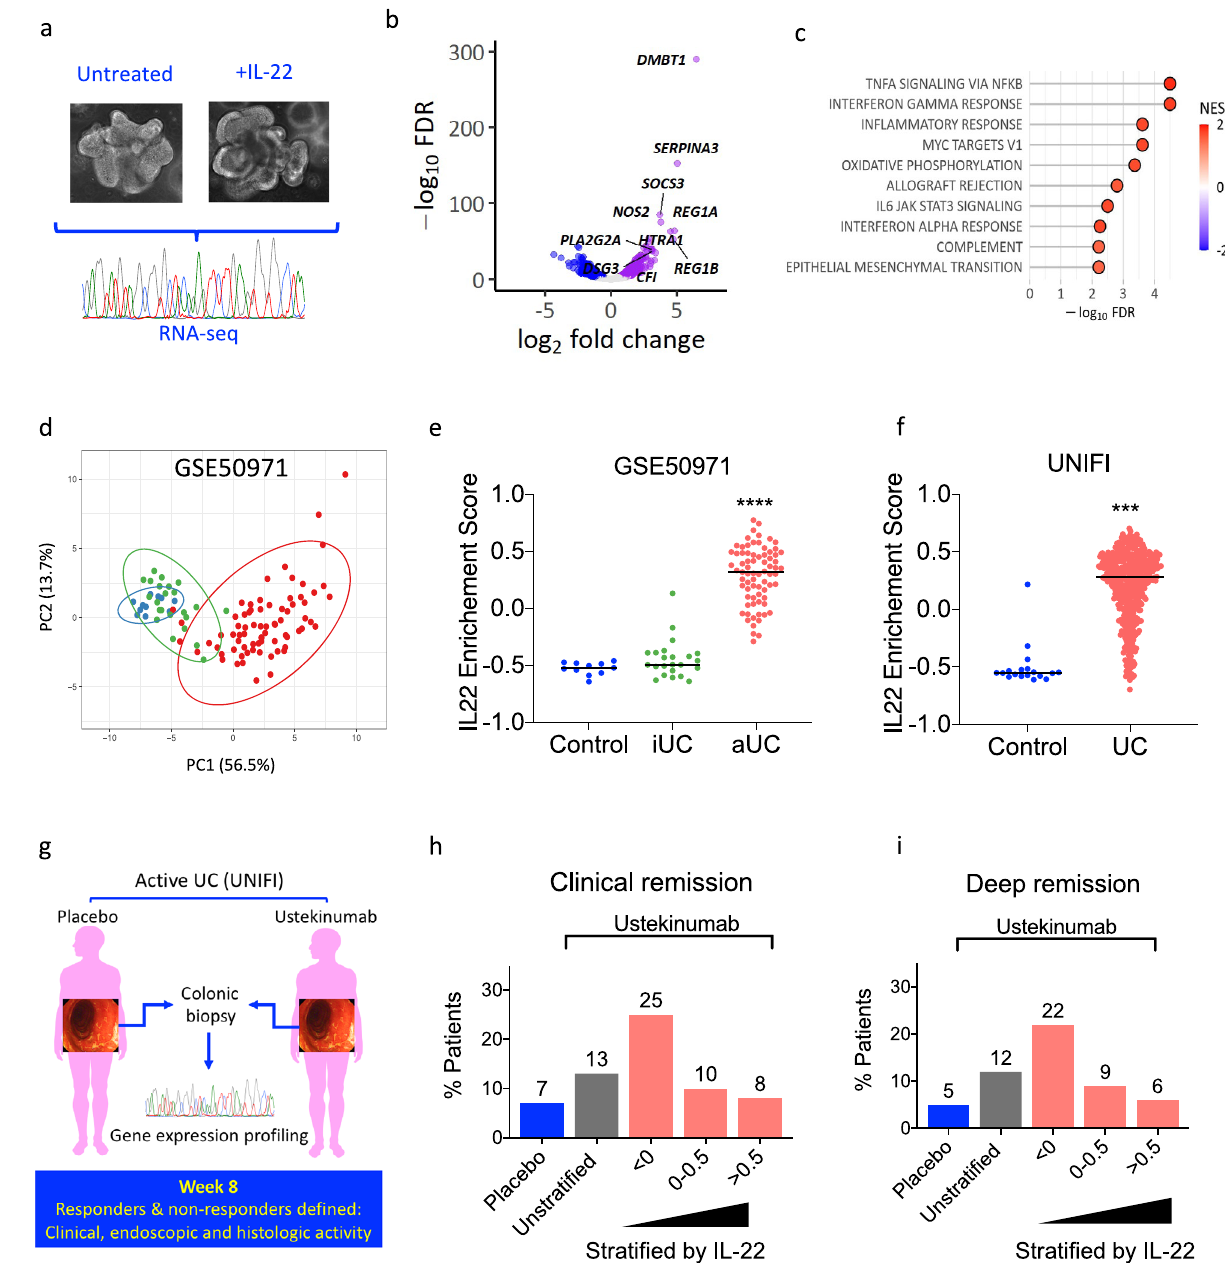
Fig. 1 | Clinical signi fi cance of the IL-22 responsive transcriptional network in ulcerativecolitis.a ExperimentalschemaofIL-22stimulationofcolonicorganoids ( n =4 biological replicates, IL-22 concentration: 10ng/ml, duration: 24h). b Volcano plot demonstrating fold change and false discovery rate (FDR) of dif- ferentially expressed genes in human colonoids treated with recombinant IL-22. c Pathwayanalysisof DEGregulated by IL-22 (top 10,hallmarkgene sets asde fi ned in MSigDB, NES: normalized enrichment score). d Expression of the top 50 upre- gulatedtranscriptsregulatedbyIL-22incolonicmucosaseparateshealthycontrols (blue, n =11),patientswithendoscopicallyinactiveUC(green, n =23)andactiveUC (red, n =74) (principal component analysis, reposited dataset: GSE50971). e Enrichment of the IL-22 regulated transcriptional program (gene set variation analysis, gene set: top 50 upregulated genes) in the reposited dataset GSE50971 (healthy control: control, iUC-inactive UC, aUC-active UC, Kruskal – Wallis test, **** p <0.0001). f Validation of the enrichment for the IL-22 regulated transcrip- tional program in biopsies taken from healthy controls (control, n =18) and